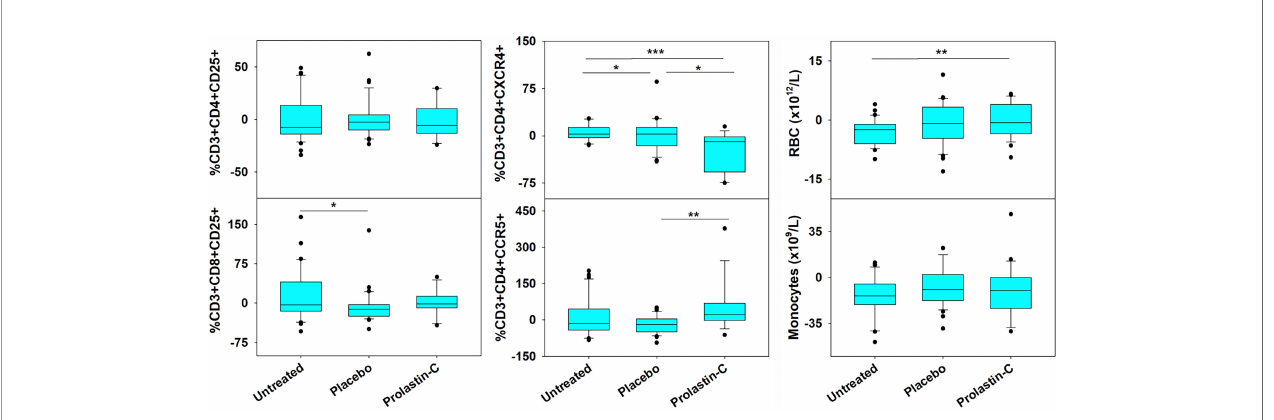
FIGURE 1 | Changes in RBC and the Number of Circulating T Cell Subpopulations in HIV-1 Infected Subjects Treated with Exogenous a 1PI. The number of longitudinal observations from the 4 uninfected, untreated subjects, 5 placebo-treated, and 3 Prolastin-C-treated subjects are n = 32, n = 36, and n = 14, respectively. Blood was collected weekly and analyzed by fl ow cytometry for CD3, CD4, CD8, CD25, CD45RA, CD45RO, CXCR4, CCR5, VLDL receptor, CD91, and CD34. Data (% of lymphocyte gate) represent % change from baseline calculated as (Baseline -Treatment)/Baseline). Red blood cells (RBC) and monocytes represent absolute values as determined from complete blood count. Askerisks designate signi fi cant differences (* P < 0.05, ** P < 0.01, *** P <